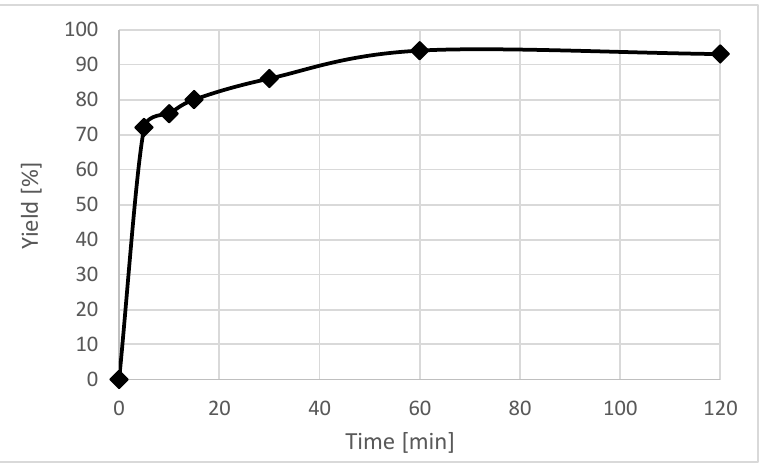
Figure 2. Time course of the reaction of 1b and benzaldehyde with NaH at −20 °C.